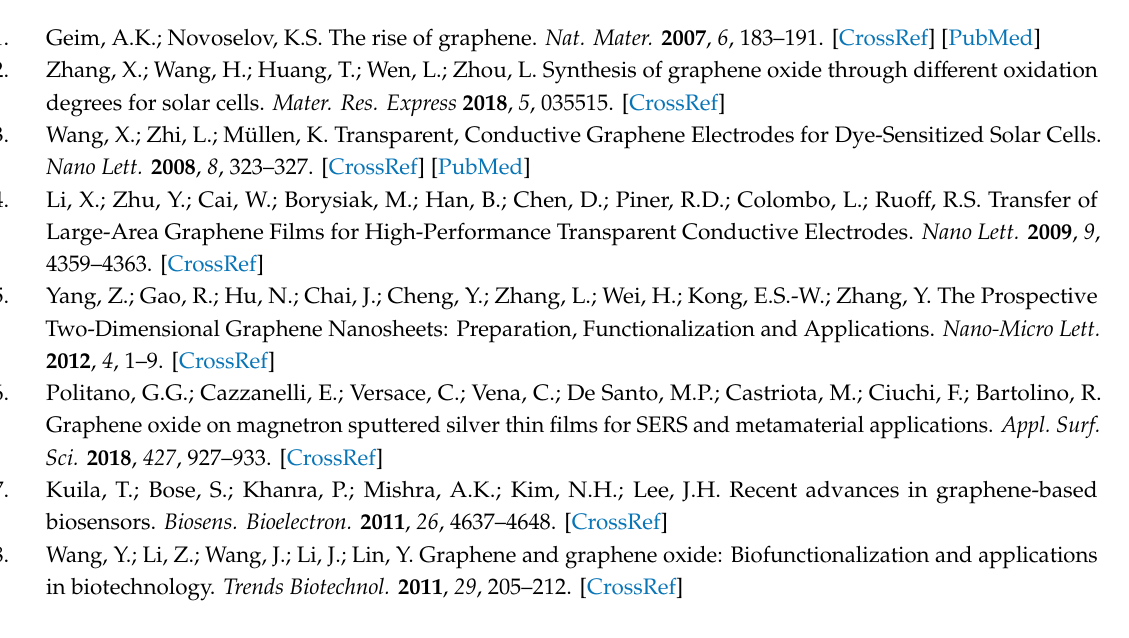
Figure S1: FAM-ssDNA and FAM-dsDNA separation by electrophoresis on 5% agarose gel, Table S1: FAM-ssDNA and FAM-dsDNA relative quantitation by densitometry, Figure S2: FAM-DNA binding to GO in the presence of SDS, BSA and NaCl, Figure S3: FAM-DNA binding to GO in the presence of SDS, BSA and NaCl, FAM-DNA + cDNA hybridization